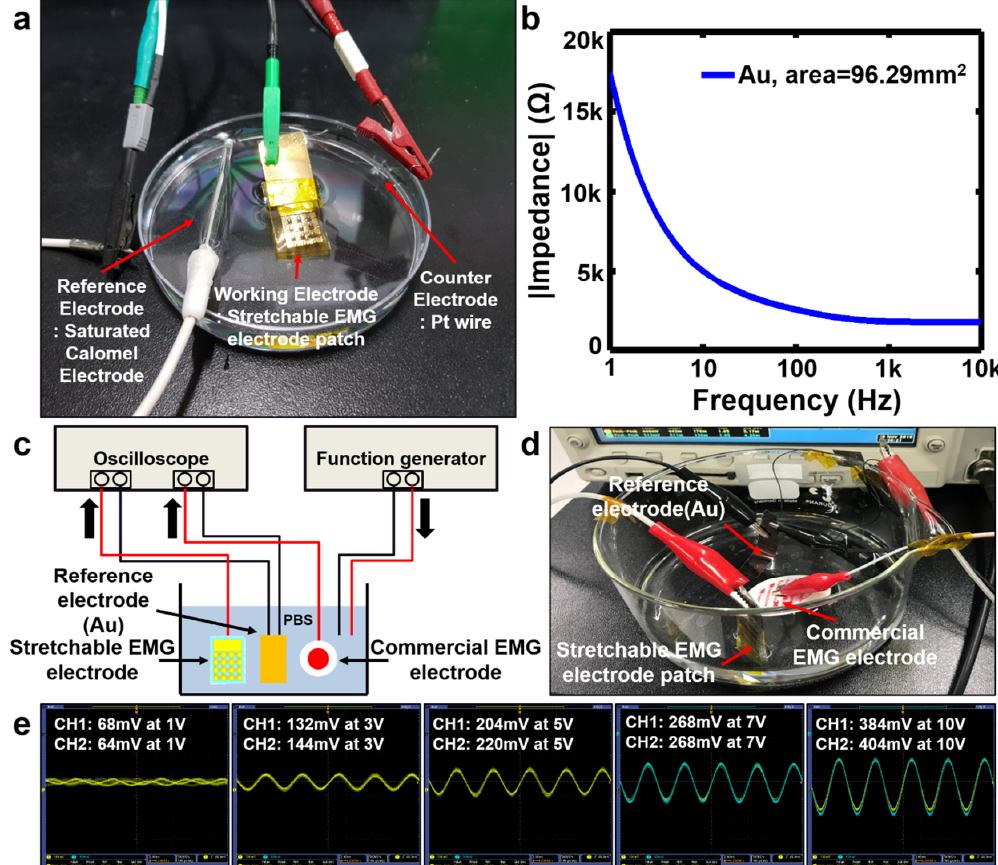
Figure 4. In vitro electrical characterization of the stretchable EMG electrode: ( a ) Experimental setup for impedance measurement; ( b ) Electrochemical impedance property of the device according to frequency; ( c ) The schematic illustration of experimental setup for evaluation of signal acquisition performance; ( d ) Sample configuration for comparison of signal acquisition performance; ( e ) Results of acquired output signal for a developed stretchable electrodes (CH1) and commercial electrodes (CH2).